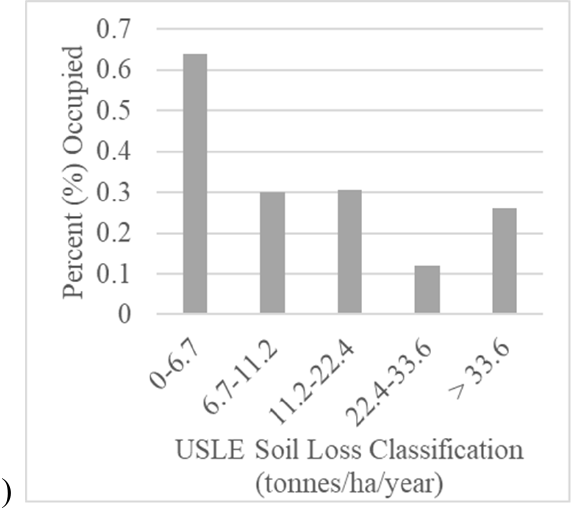
Figure 7. Proportion of agriculture that incorporates cover crops at 1:6 ( A ), 2:6 ( B ), 3:6 ( C ) frequencies on soil loss severity.